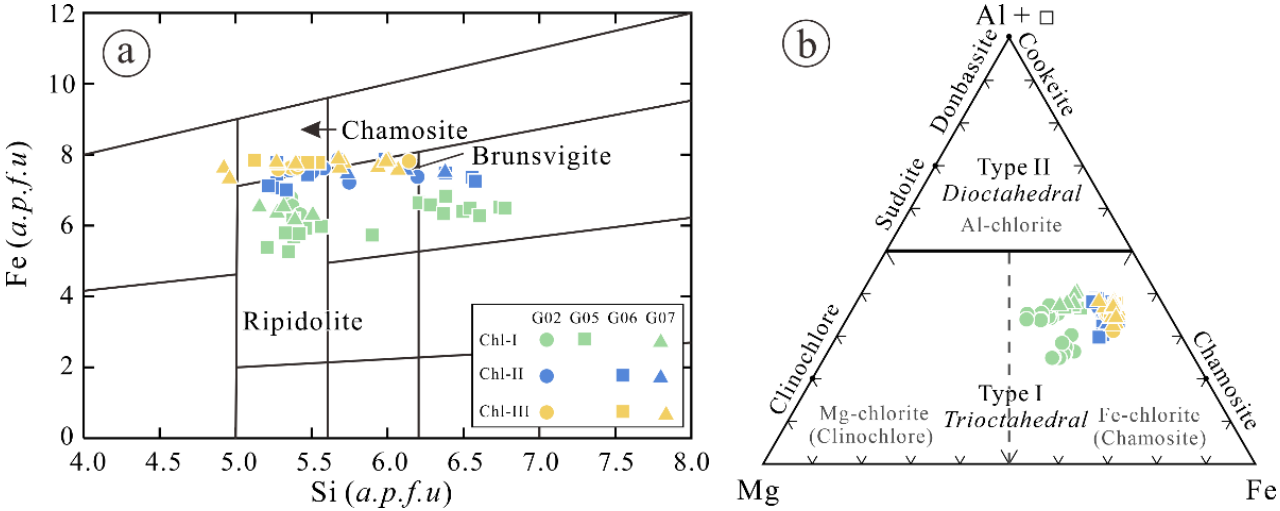
Figure 4. Chlorite classification diagrams in the Gongchangling alteration rocks. ( a ): Si vs. Fe (a.p.f.u) after [26] ( b ): (Al + □)– Mg – Fe, reprinted with permission from Zane et al., 1998 Ref. [27].